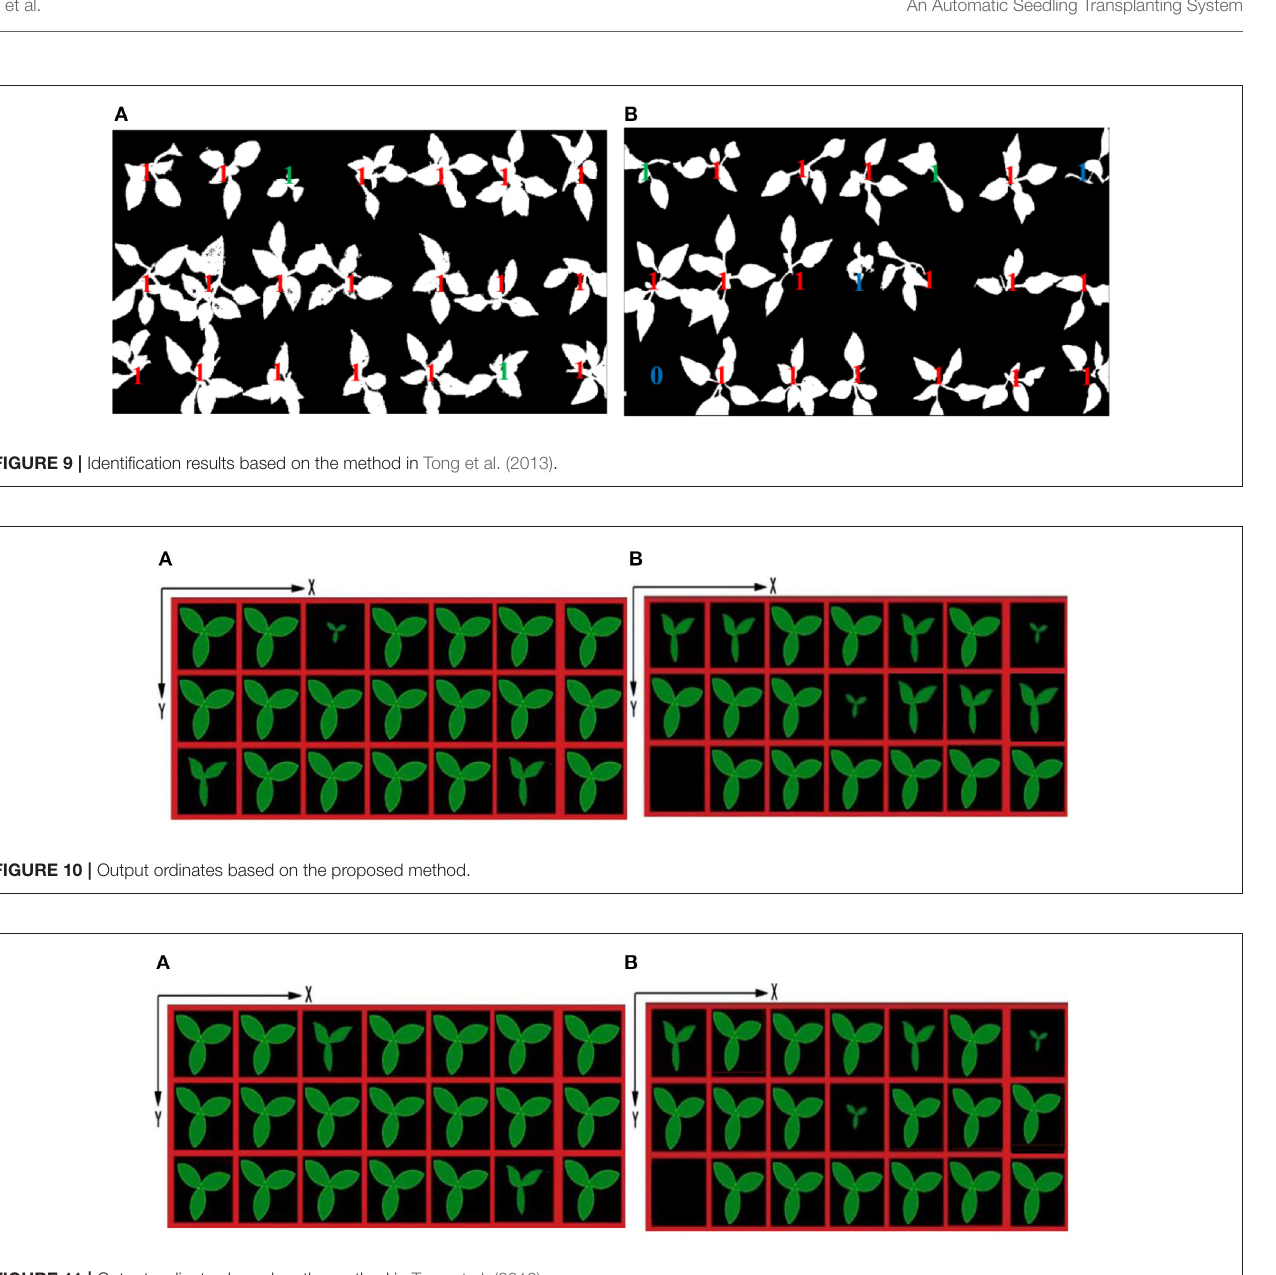
FIGURE 11 | Output ordinates based on the method in Tong et al.